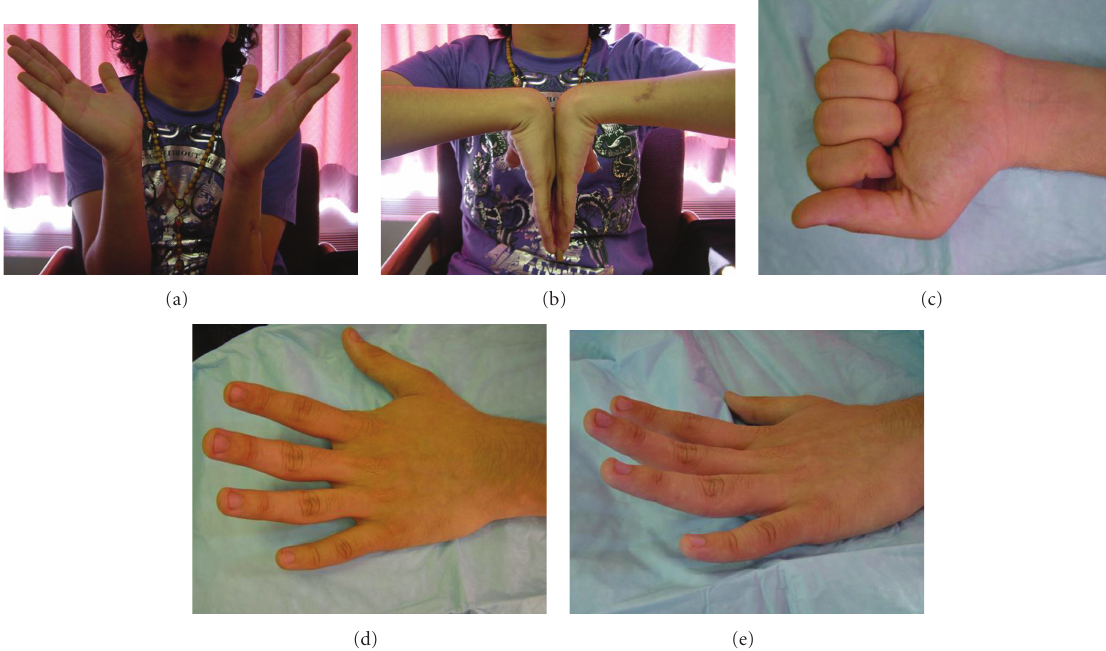
Figure 4: Seven months postoperative ROM of 18-year-old RHD male who sustained a laceration to his left dorsal forearm. The motion is as follows: (a) 50 ◦ wrist extension; (b) 90 ◦ wrist flexion; (c) full finger flexion into a fist; (d, e) full finger extension o ff table.